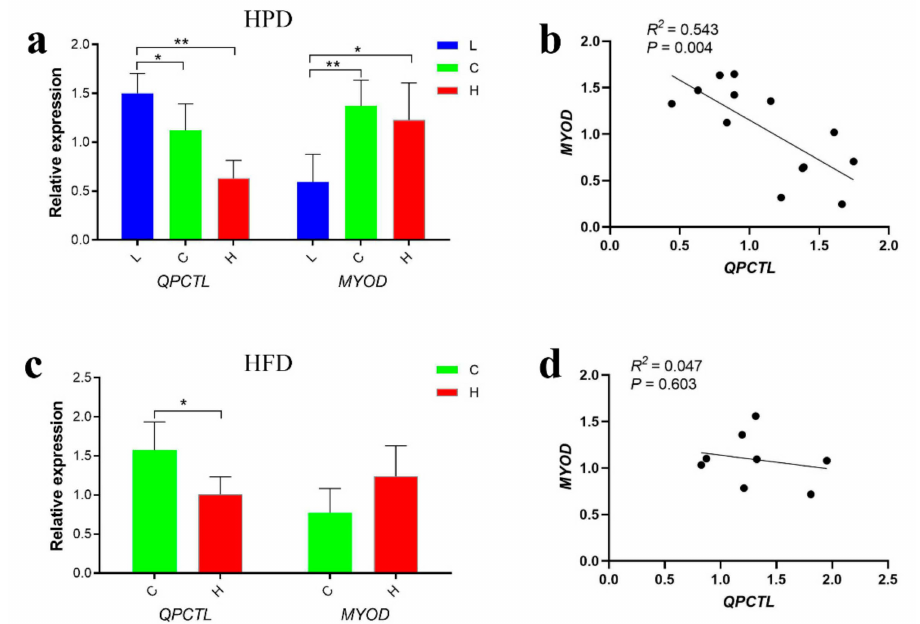
Figure 5. Trend analysis of QPCTL and MYOD gene expression. ( a ) Expression of QPCTL and MYOD genes in breast muscle of Gushi chickens fed a high-protein diet ( n = 18). ( b ) Correlation analysis of QPCTL and MYOD gene expression in chickens fed a high-protein diet. ( c ) Expression of QPCTL and MYOD genes in breast muscle of Gushi chickens fed a high-fat diet ( n = 10). ( d ) Correlation analysis of QPCTL and MYOD gene expression in chickens fed a high-fat diet. * p < 0.05; ** p < 0.01.